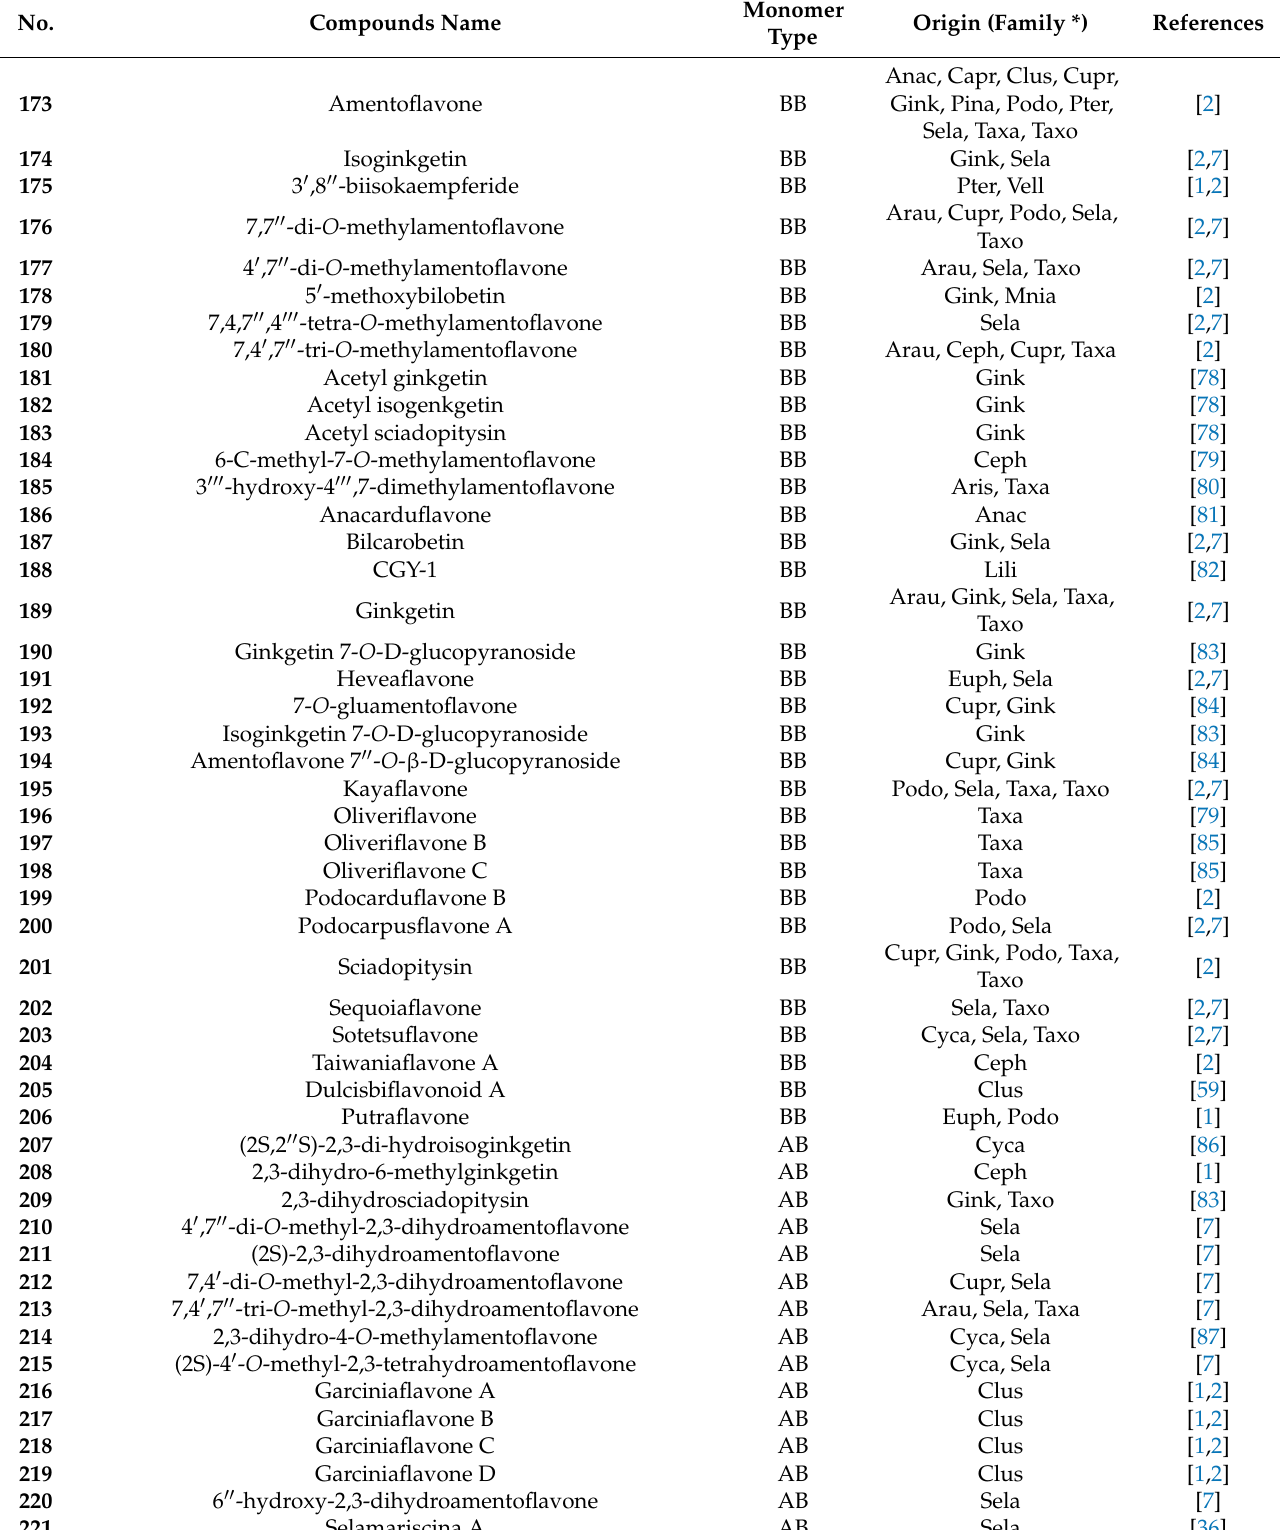
Table 4. The 3 (cid:48) -8 (cid:48)(cid:48) subtype of